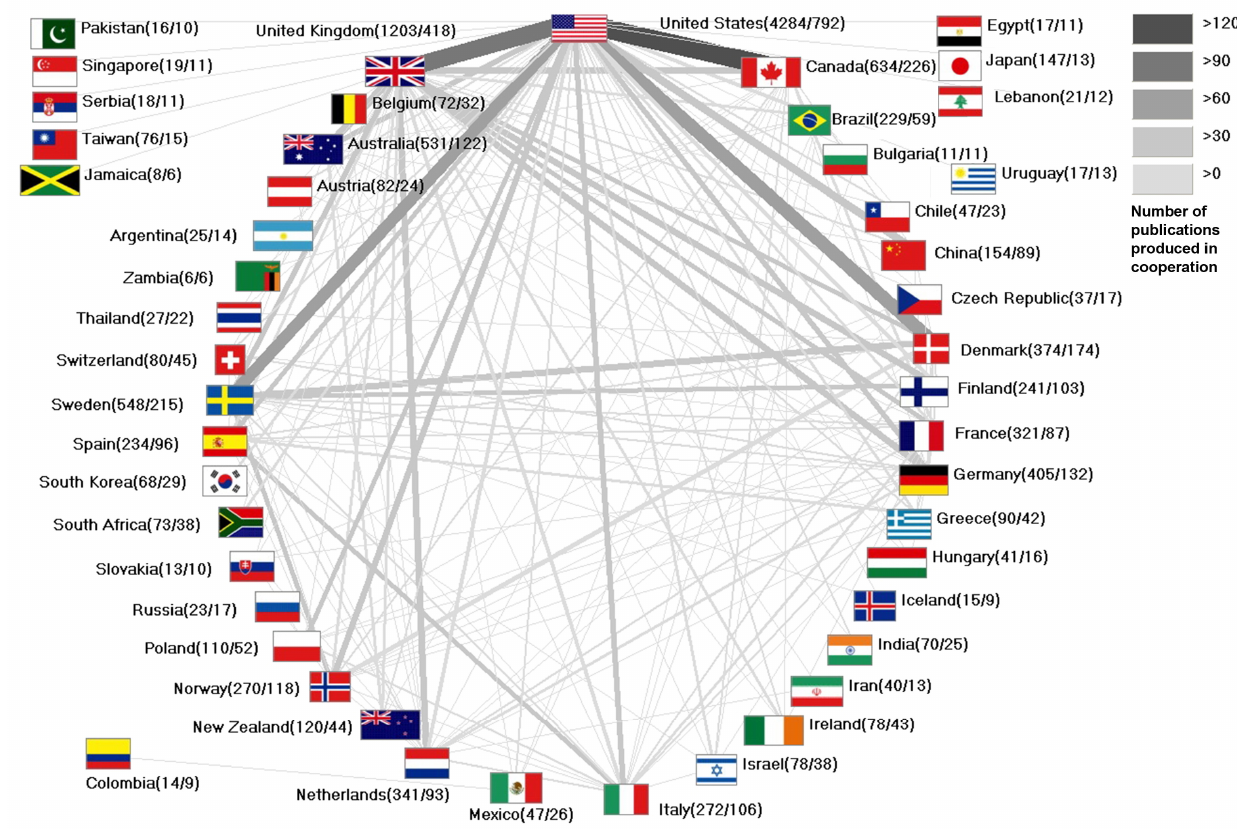
Figure 3. Cooperations of